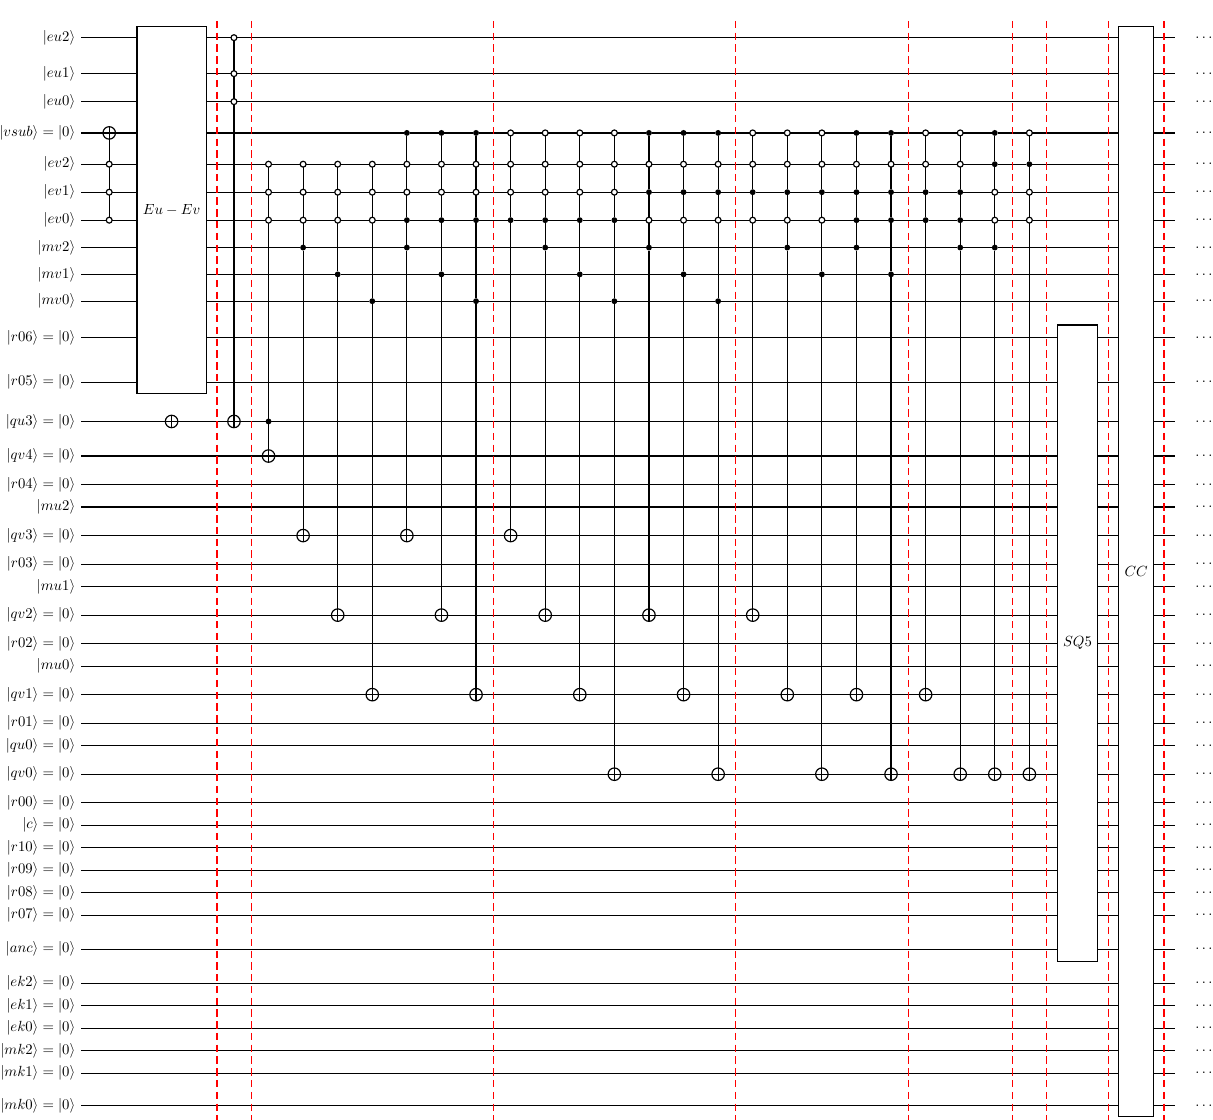
qubit mantissa squaring output −